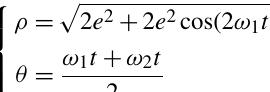
2( e 1 + e 2 ) as external diameter, 2 | e 1 − e 2 | as internal